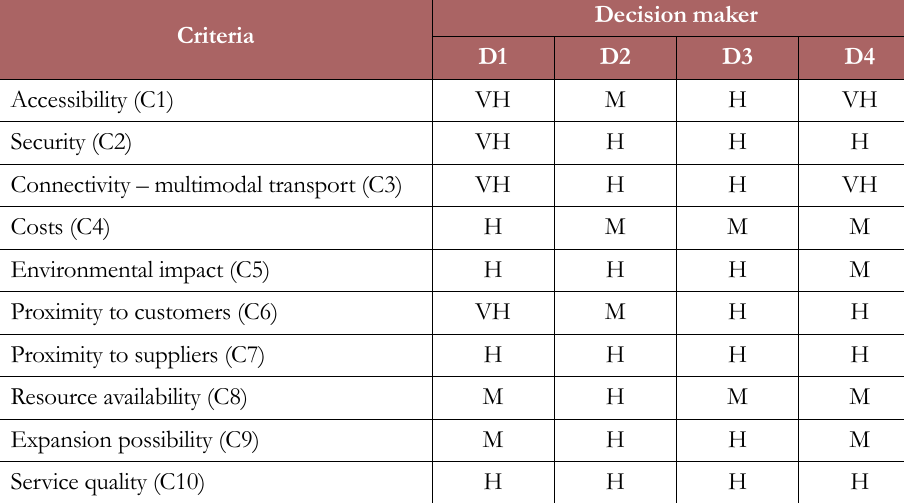
Table 6. Linguistic assessment for the